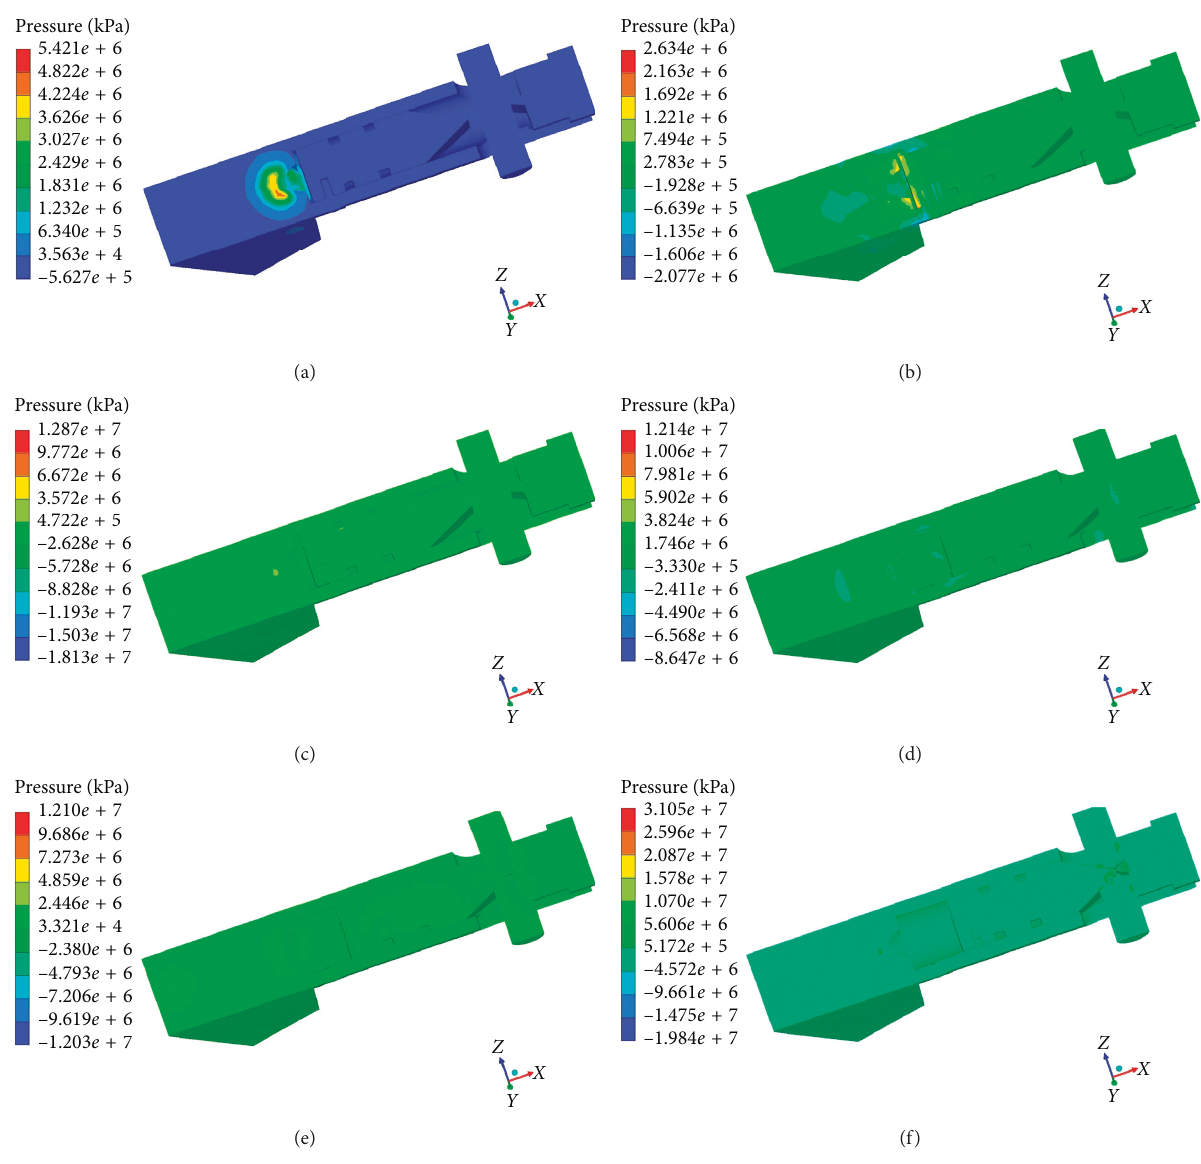
Figure 5: Pressure contours for the pyrotechnic cutter during its actuation. (a) 0.001 ms (b) 0.004ms. (c) 0.028ms (d) 0.078ms. (e) 0.144ms. (f)